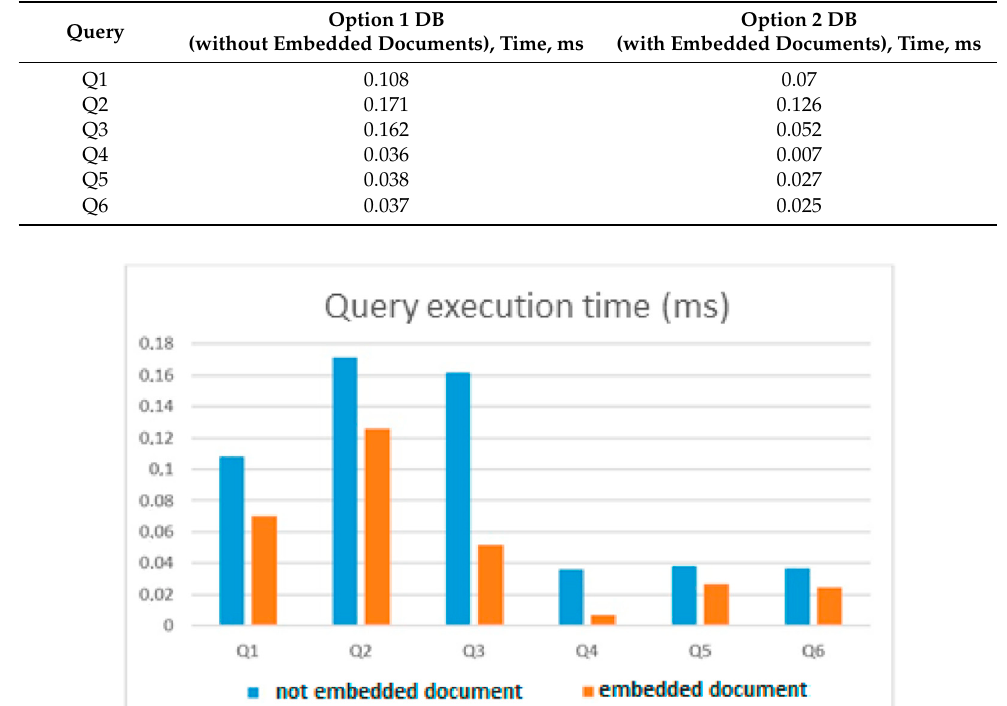
Figure 12. The new collection with sequential and multi-level embedded documents. To test these two variants of the MongoDB database, eight queries were executed, differing in their structure. The average value of the query execution time is presented in Table 3 and in Figure 13. Examples of queries are given in Appendix B. We have tested the method on databases of various contents and structure. In this article, we have demonstrated three of the most revealing examples that can be schematically represented as follows (Table 4):